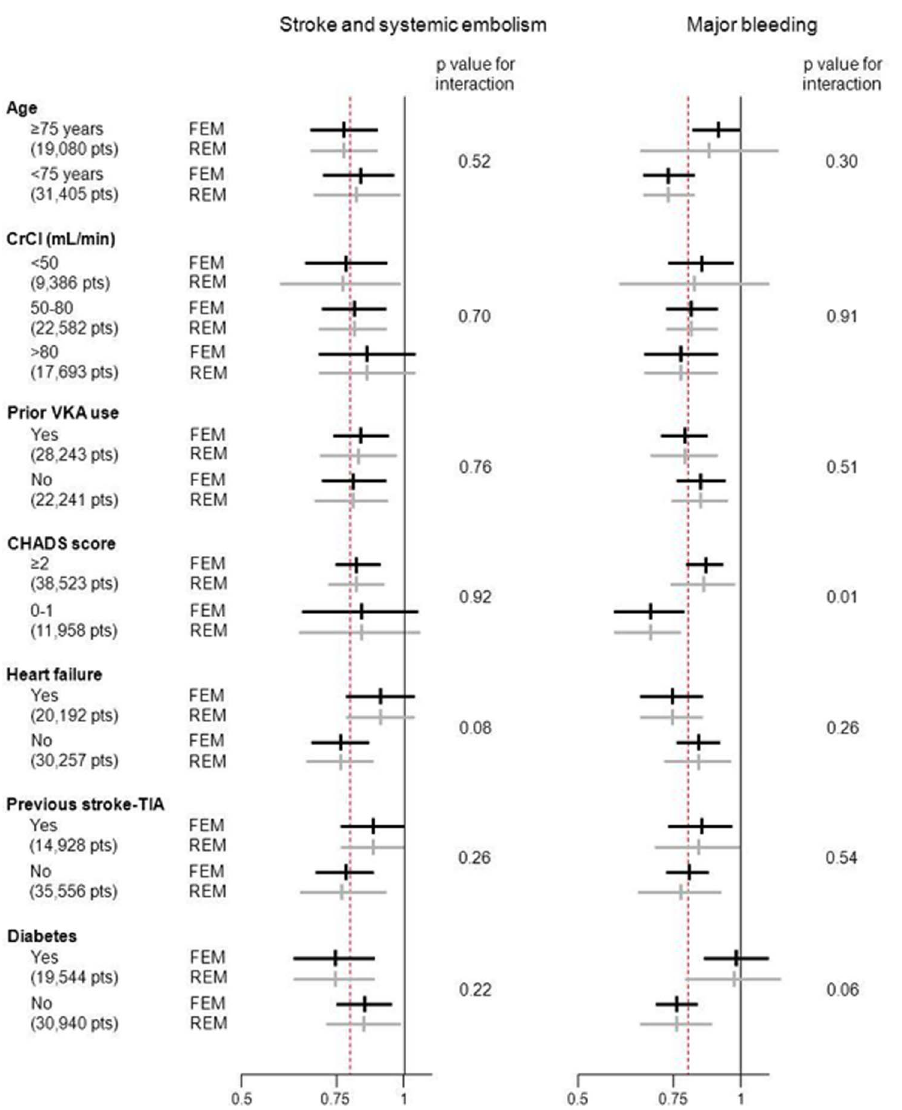
Figure 2. Relative risk of stroke and systemic embolism and major bleeding reduction according to age, comorbidities and VKA